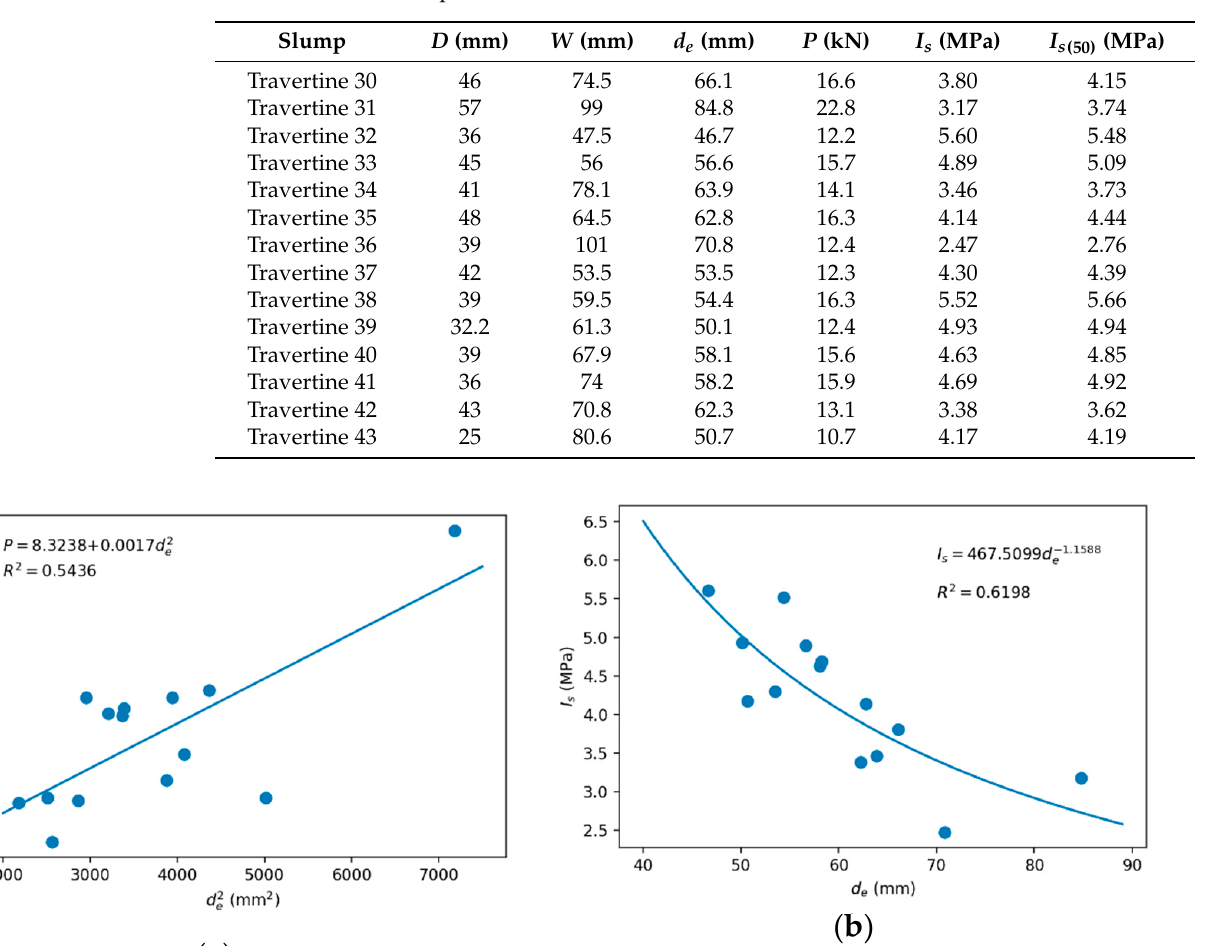
Table 7. Results of the point load test on travertine.